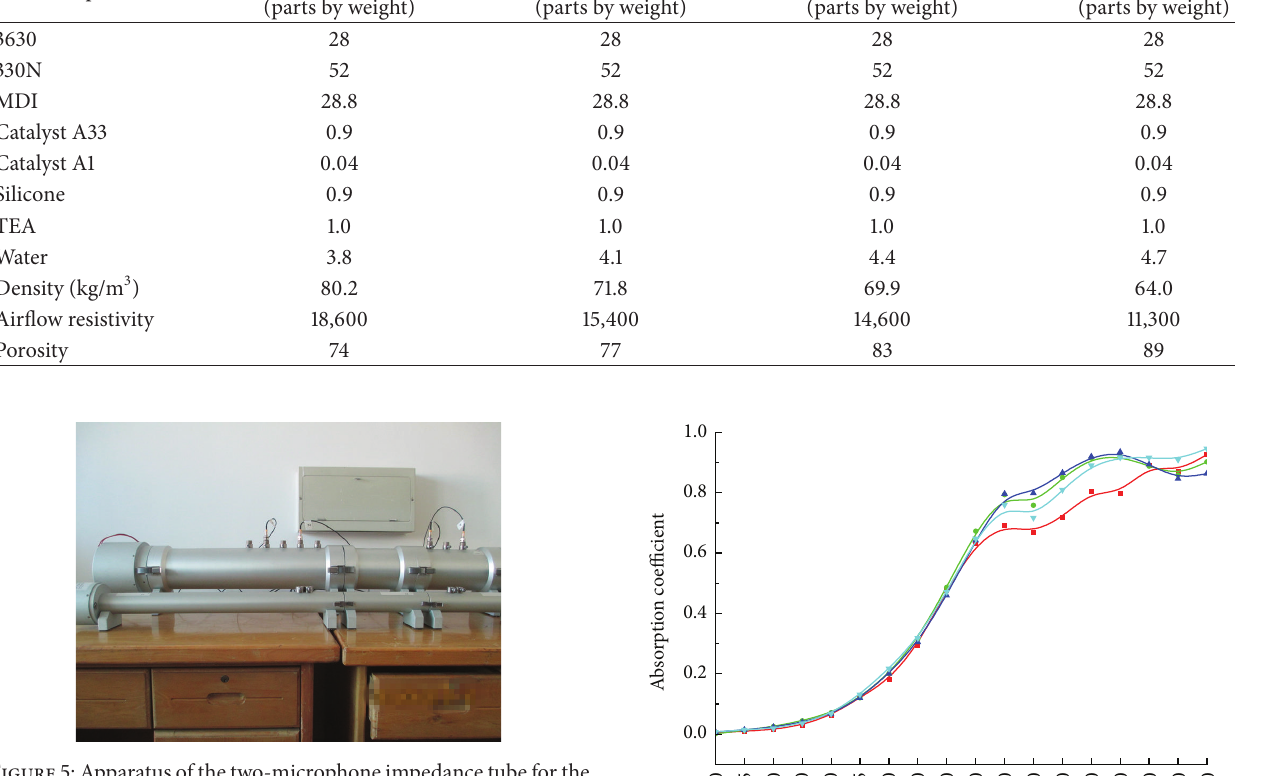
Figure 5: Apparatus of the two-microphone impedance tube for the ASTM-E-1050: absorption testing.